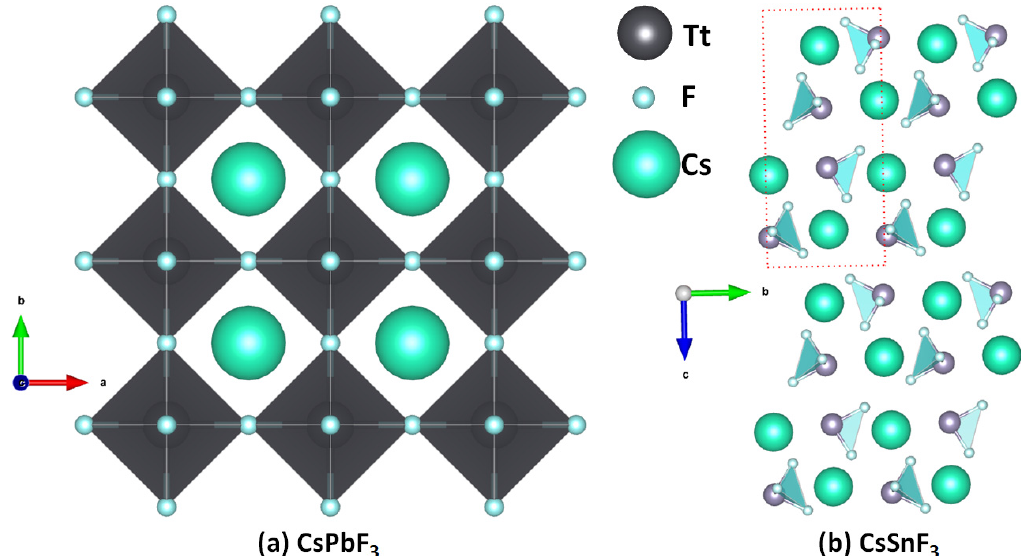
Figure 11. The crystal structure of ( a ) cesium lead fluoride perovskite [CsPbF 3 ] (ICSD ref: 93439) and ( b ) low-dimensional cesium tin fluoride [CsSnF 3 ] (ICSD ref: 236903).